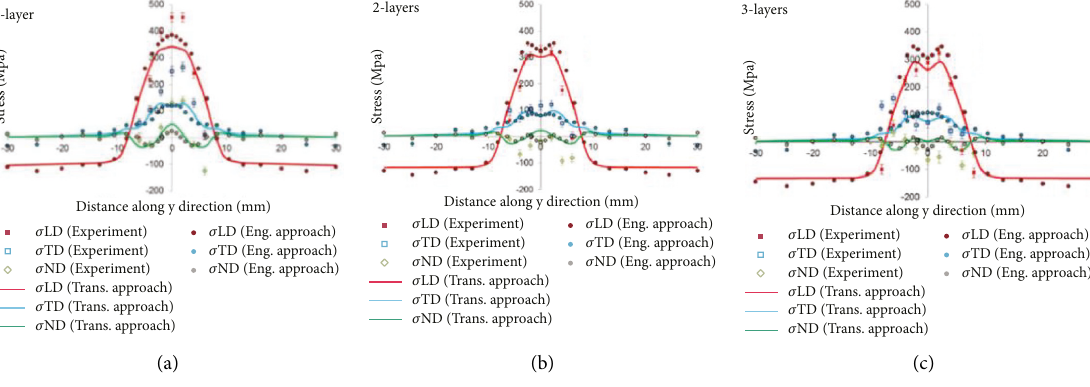
Figure 4: Stress comparison in the longitudinal (LD), transverse (TD), and normal (ND) directions along a transverse line halfway along the base plate, 2mm below the top surface for single (a), two (b), and three layers